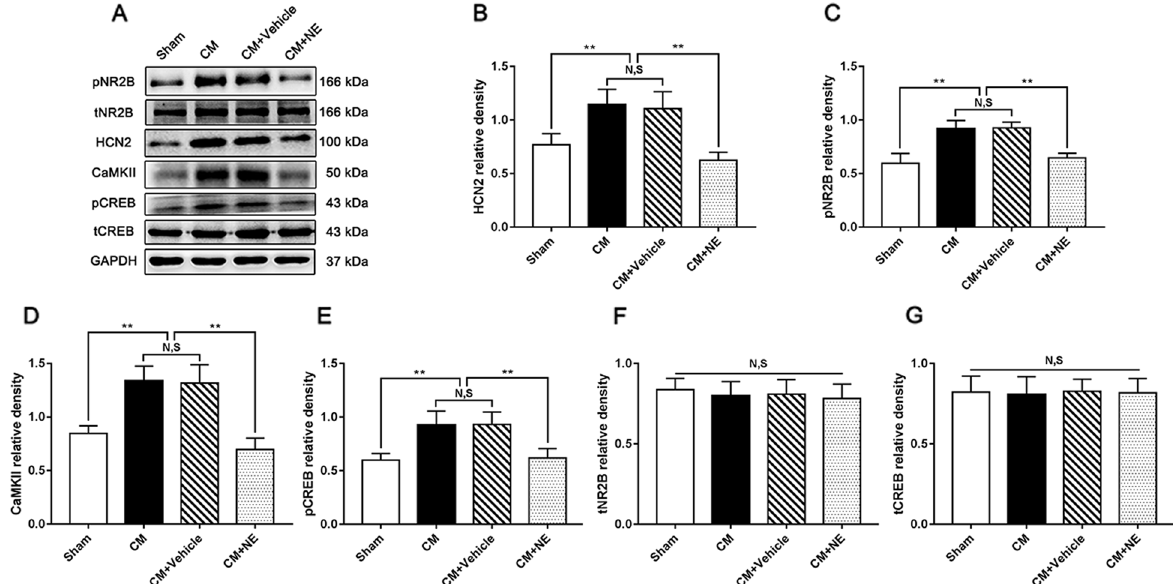
Fig. 5 The effect of NE on HCN2 and the pNR2B/CaMKII/pCREB pathway in CM rats. A Representative western blots of HCN2, pNR2B, CaMKII, pCREB, tNR2B, and tCREB. B-E The expression levels of HCN2, pNR2B, CaMKII, and pCREB were obviously increased in the CM group compared with those in the Sham group, and there was no statistical difference between the CM and the CM expression levels in the CM NE group sharply reduced compared to the CM + There was no substantial difference in tNR2B and tCREB expression levels among the Sham, CM, CM S, not significant)